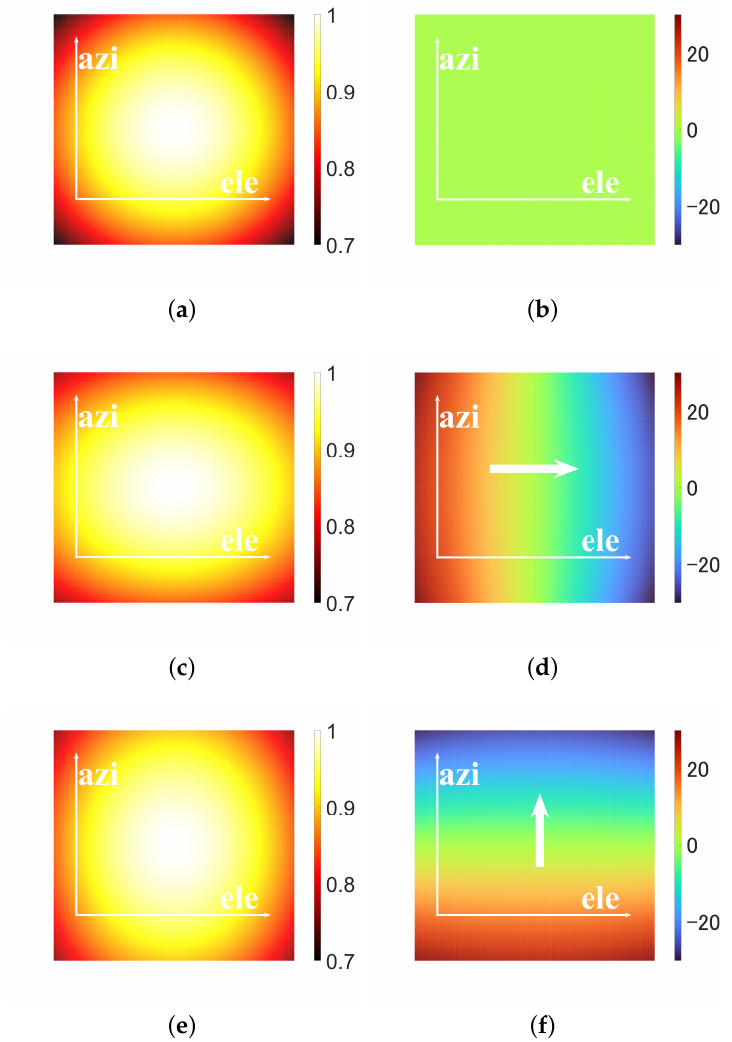
Figure 2. Comparison between the plane beam and the modulated beam. ( a ) The pattern of the plane beam. ( b ) The phase pattern of the plane beam. ( c ) The pattern of the modulated beam I. ( d ) The phase pattern of the modulated beam I. ( e ) The pattern of the modulated beam II. ( f ) The phase pattern of the modulated beam II. Table 1. Relative amplitude coefficients of beams.